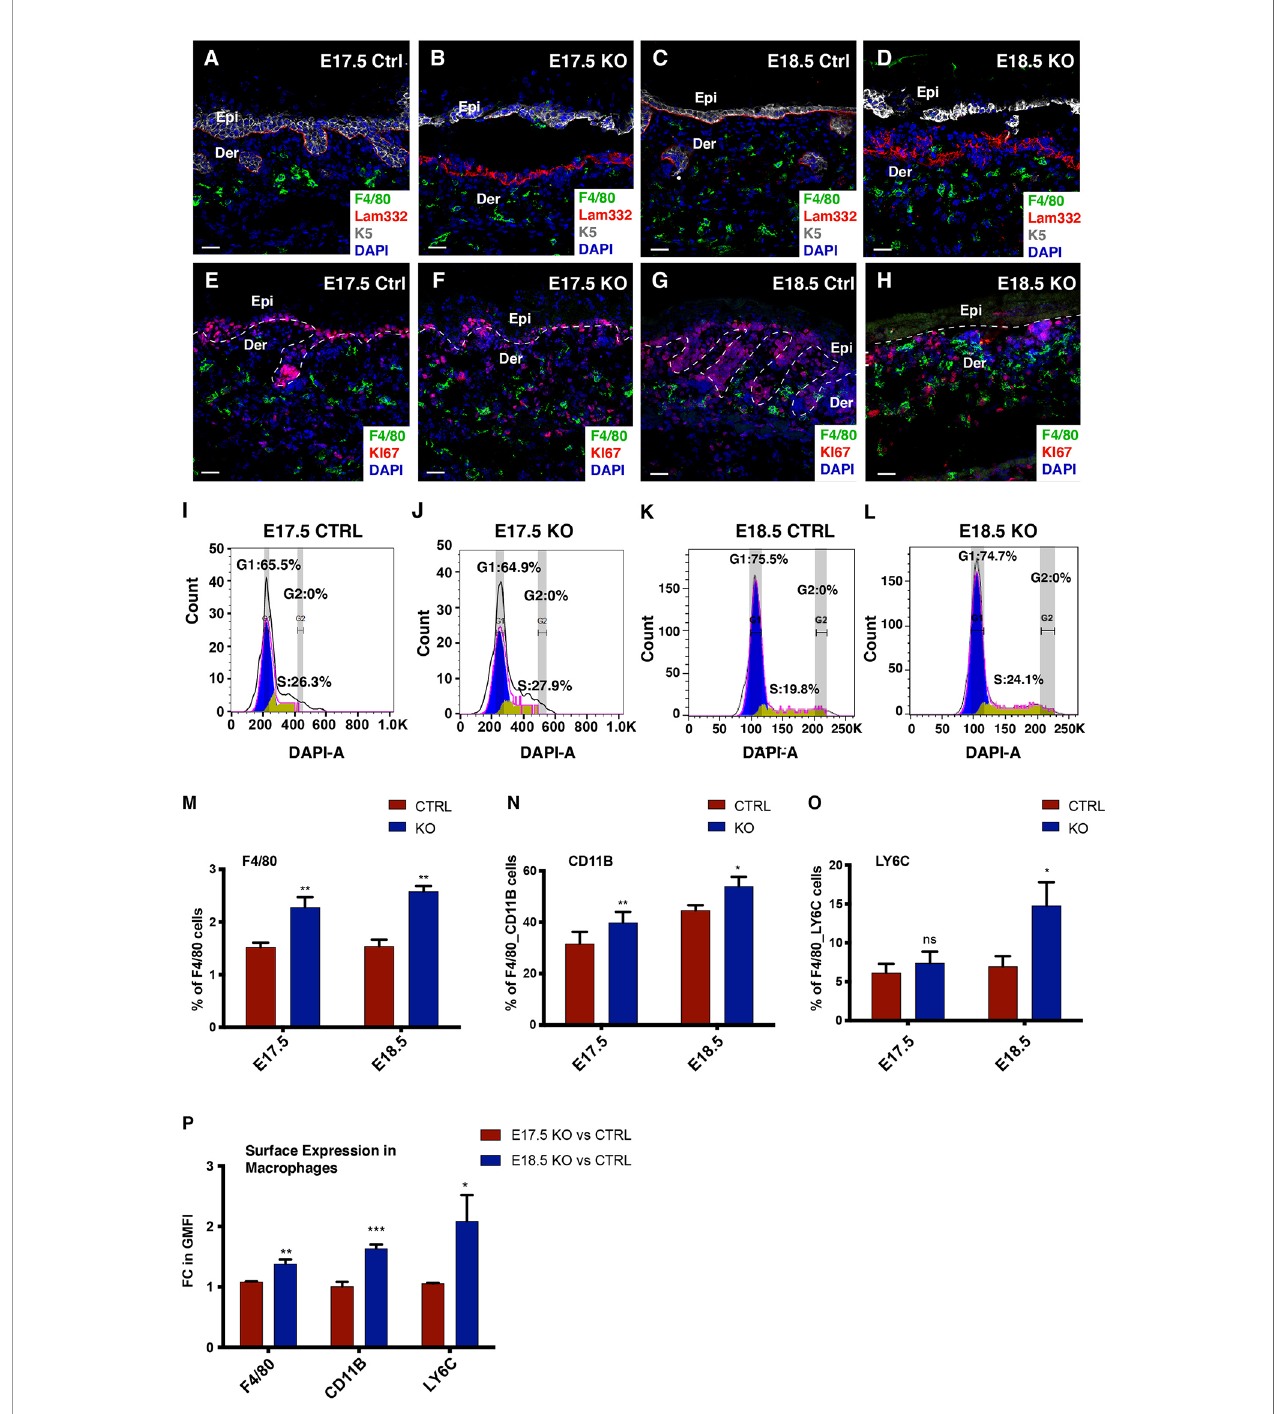
FIGURE 1 | Macrophages are the major immune cells in the E18.5 skin and are derived from the circulatory monocytes. Increase in the macrophage population and BM disruption in the Itg b 1 epidermal KO skin compared to the control skin depicted by the immunostaining for F4/80, Laminin 332 (Lam-332), and Keratin 5 (K5) at E17.5 (A, B) and E18.5 (C, D) . Immunostaining of F4/80 cells with Ki67 in the control and the Itg b 1 KO skin at E17.5 (E, F) and E18.5 (G, H) . White dashed lines mark the dermal (Der)-epidermal (Epi) separation. Cell cycle analysis at E17.5 and E18.5 in the control and the KO embryonic skin (I – L) . Bar graphs representing percentage of F4/80 cells in the E17.5 and E18.5 control and the KO skin (M) (N=2). Quanti fi cation of the fl ow cytometry data in the E17.5 and E18.5 control and tg b 1 epidermal KO skin for the expression of F4/80 + CD11B + (N) and F4/80 + LY6C + (O) in sorted CD45 + cells (N=3). Quanti fi cation of the normalized geometric mean fl uorescence intensity (GMFI) expression of F4/80, CD11B, and LY6C on the macrophages in the E18.5 compared to the E17.5 KOs (P) (N=3). Scale bars: 20 µm. *p ≤ 0.05, **p ≤ 0.01, ***p ≤ 0.001, ns=not signi fi